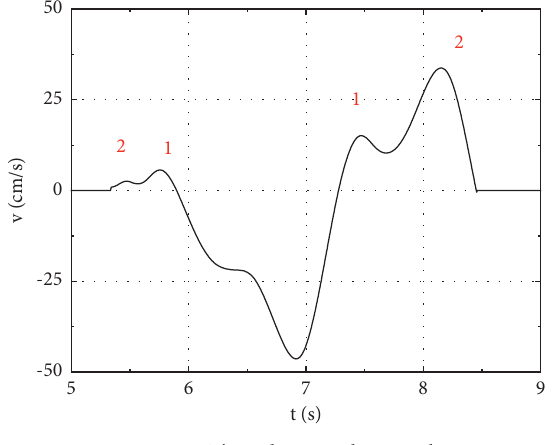
Figure 8: The velocity pulse signal.